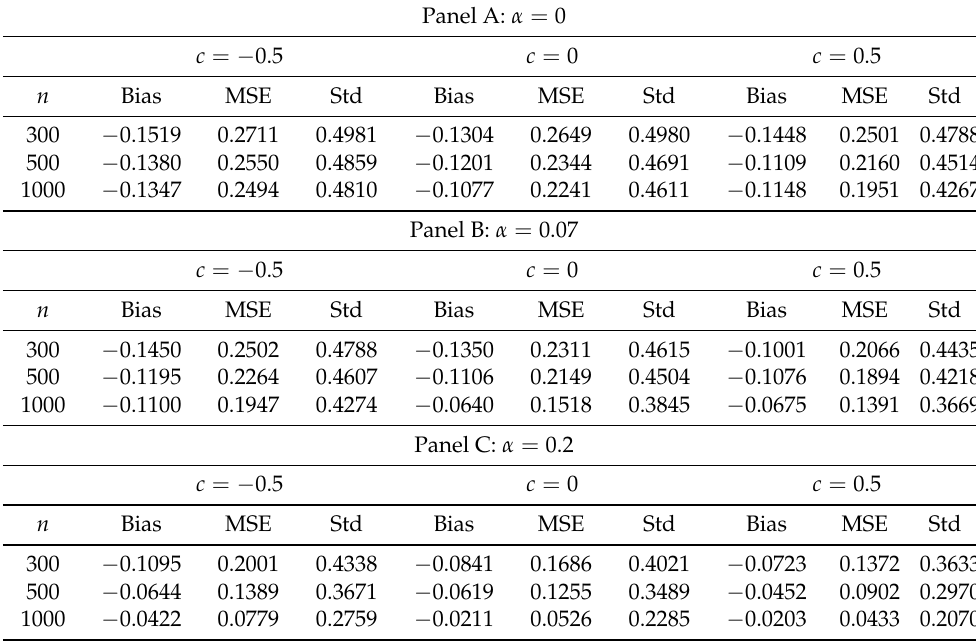
Table 2. Simulation results with ρ = 1/4.